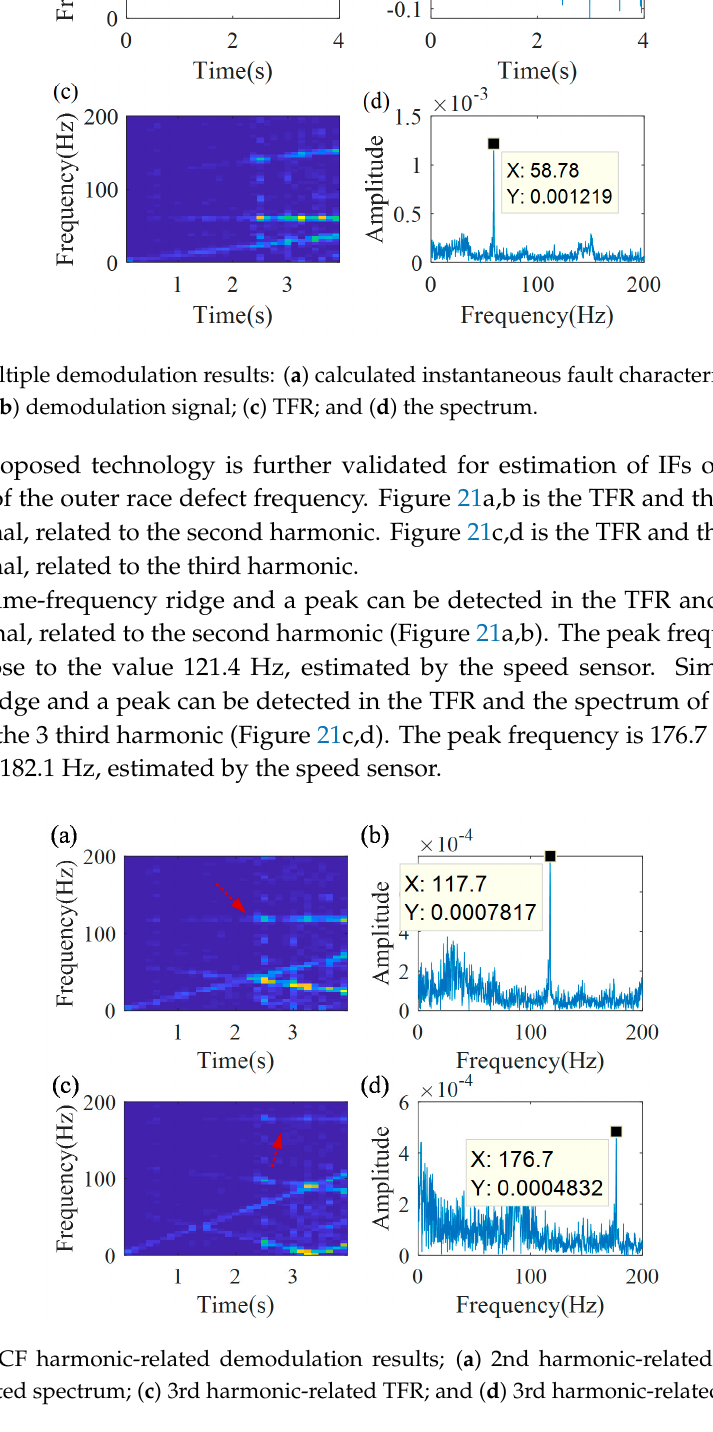
Figure 19. Second iteration demodulation results: ( a ) extracted IFs; ( b ) demodulated signal; ( c ) TFR; and ( d ) spectrum.